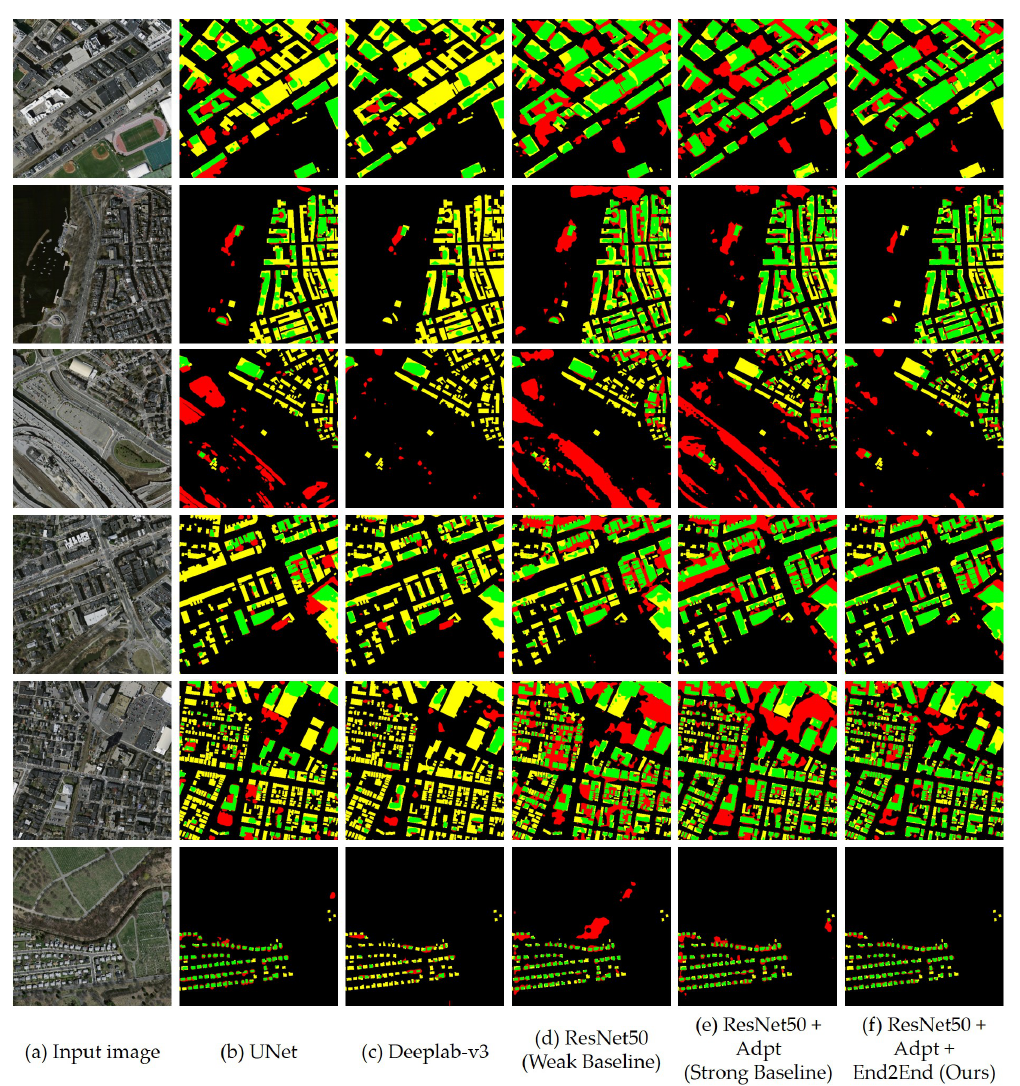
Figure 5. (Better viewed in color) Some building segmentation results of different methods: ( a ) Input Image, ( b ) UNet [31], ( c ) Deeplab-v3 [29], ( d ) ResNet50-FCN (our weak baseline), ( e ) ResNet50-FCN + Adapt (our strong baseline) and ( f ) ResNet50-FCN + Adapt + End2End (our full implementation). Green pixels: true positives. Yellow pixels: false negatives. Red pixels: false